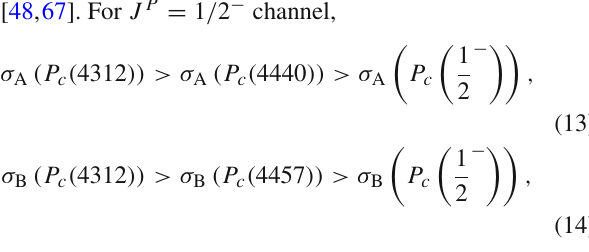
cut | η | < 0 . 5 is implemented for charm quark to compare with the √ s = 7 TeV com- experimental data. The black box and blue triangle points are for the experimental data and MC results,